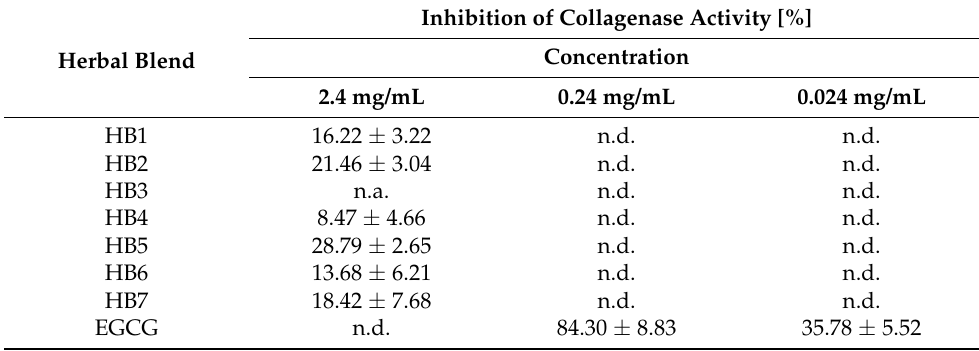
Table 8. Inhibition of collagenase activity by the infusions from herbal blends.